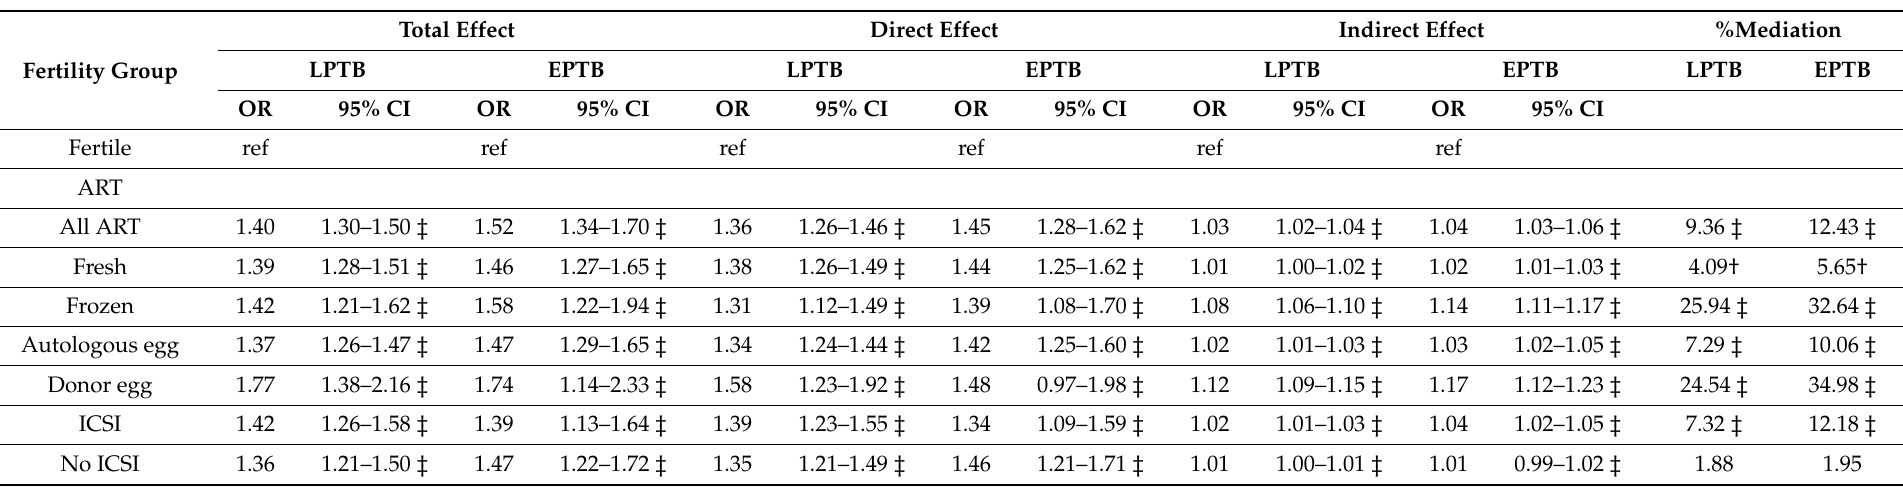
Table 4. Mediation analysis with Pregnancy-Induced Hypertension as